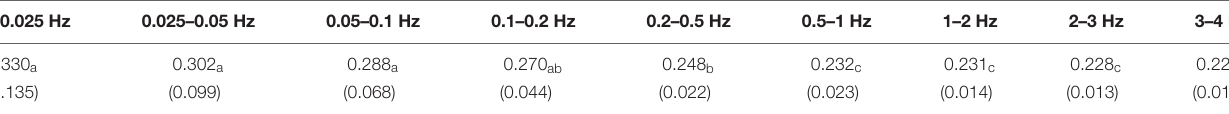
TABLE 1 | Means and standard deviations of wavelet coherence for each frequency component.